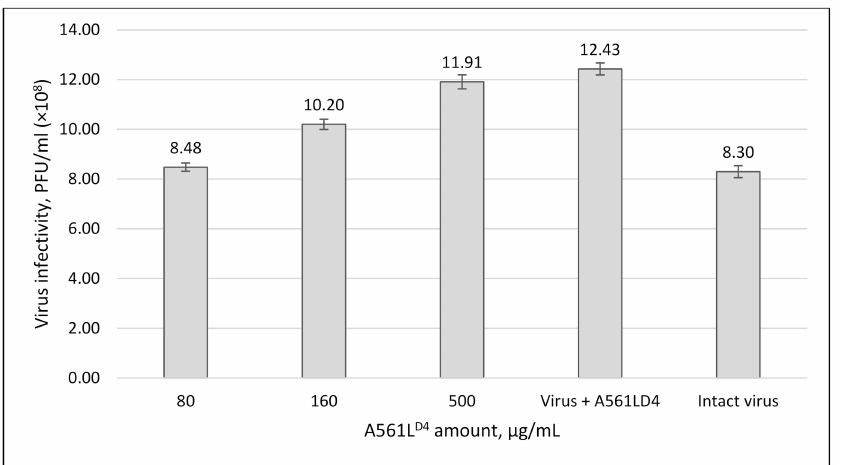
Figure 6. Effect of the soluble product resulting from A561L D4 treatment of C. variabilis NC64A ghost cells on PBCV-1 virus infectivity to determine if A561L D4 treatment resulted in the release of intact host receptor. Supernatant fractions collected from the experiment in Figure 5 were collected and PBCV-1 virus was added to the collected supernatant fraction at a concentration of 10 9 PFU/mL and incubated for ~1 h at room temperature. Serial dilutions of the supernatant fractions were made and virus infectivity was plaque assayed. Clearly, the host receptor was not released intact by A561LD4. Note, however, that exposure of purified PBCV-1 to A561L D4 resulted in an ~50% increase in the specific infectivity of PBCV-1. Results are plotted as mean ± standard deviation ( n = 10), p -value